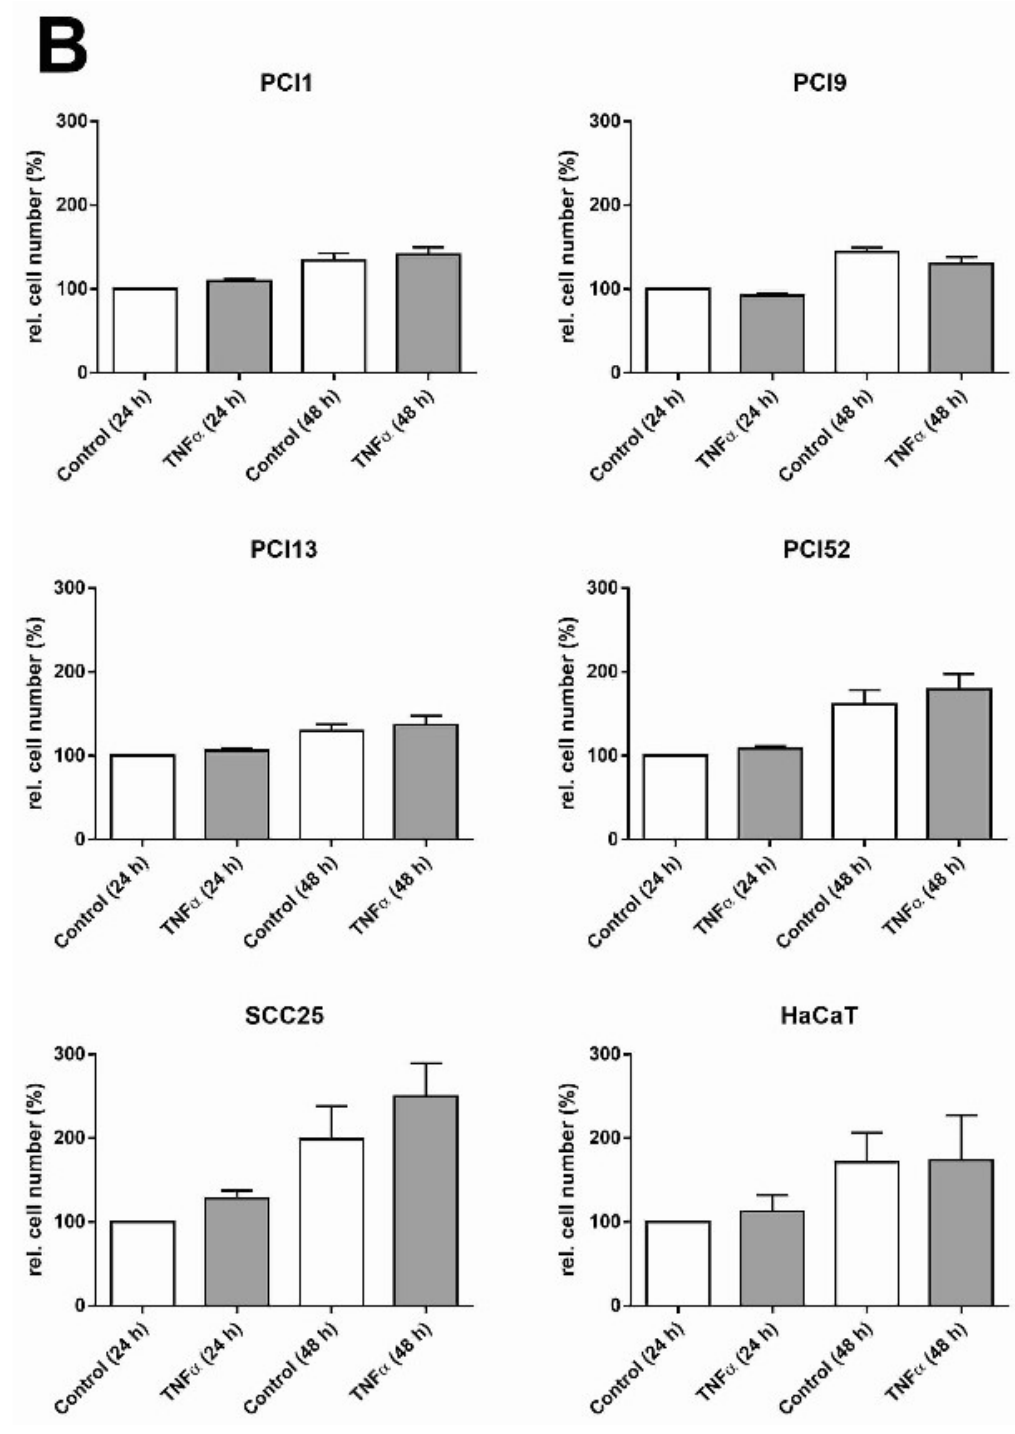
Figure 1. Cells (2 × 10 4 /well) were stimulated with or without TNF α (100 ng/mL) for 24 and 48 h. ( A ) IL-8 secretion was measured via ELISA of the supernatants. ( B ) Relative cell number (RCN) was measured via a crystal violet assay of the corresponding 96-well plate. RCN values were normalized to those of the 24 h control group (100%). Three independent experiments were performed to determine mean values and standard deviations ( n = 3), which are presented above. Results were calculated by Wilcoxon rank-sum test. p < 0.05 indicates statistically significant IL-8 inducing effects of TNF α marked with *, highly significant p -values (<0.01) with ** and very highly significant p -values (<0.001) marked with ***.